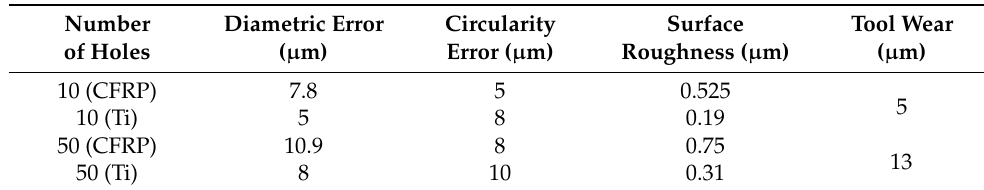
Table 13. Output Parameters at Optimal Flank Wear.